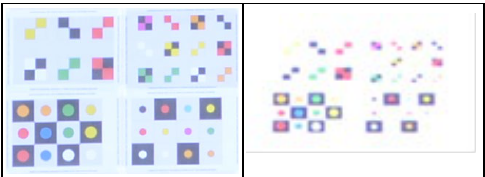
Figure 2. Tested targets on the simulated nadir and oblique